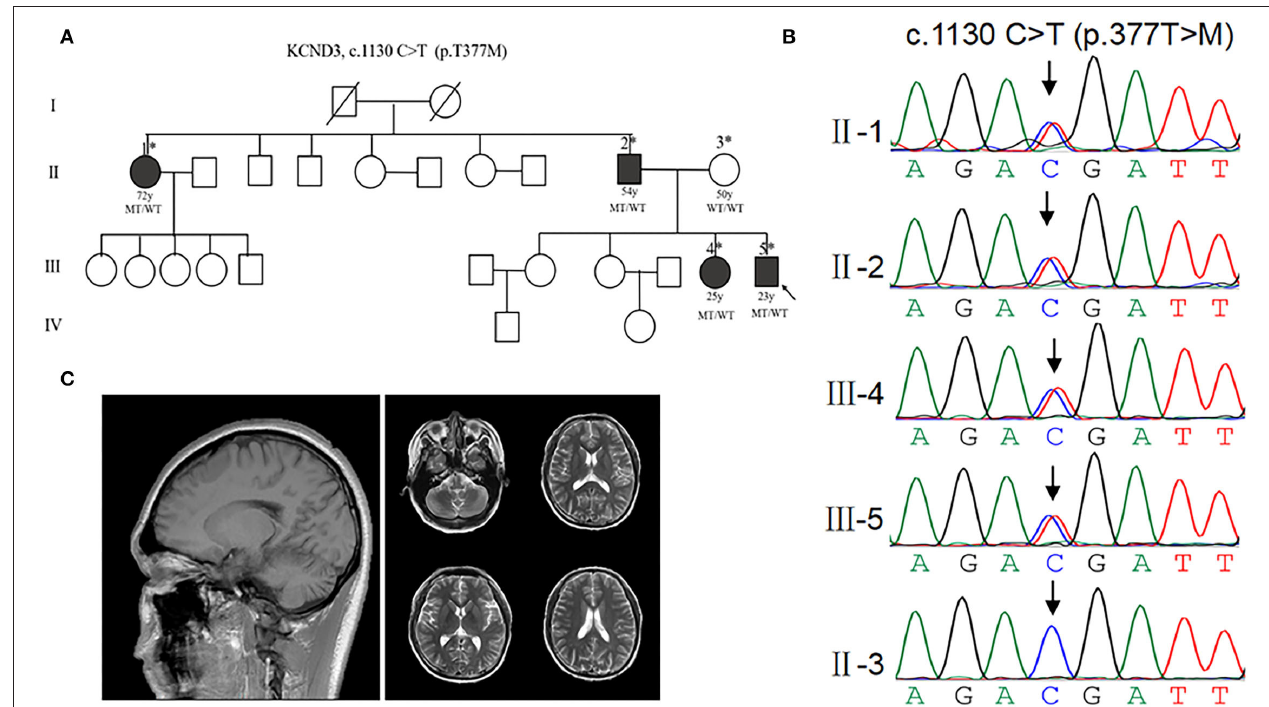
FIGURE 2 | Clinical characterization of KCND3 mutations. (A) Pedigree chart: there are four patients in this family. The asterisks indicate that the members have been sequenced. The arrows denote probands. The filled symbols represent symptomatic members. The open symbols indicate unaffected individuals. The circles indicate female participants. The squares indicate male participants. The diagonal lines refer to the deceased. WT/WT refers to wild-type, while MT/WT specifies heterozygous mutation. (B) Sequencing chromatograms. Sanger sequencing verified the c.1130 C > T (p.T377M) mutation of the KCND3 and showed pedigree co-separation in this family. This mutation of KCND3 was not found in the normal family members. (C) No cerebellar atrophy and white matter abnormalities were found in III-5’s brain MRI.